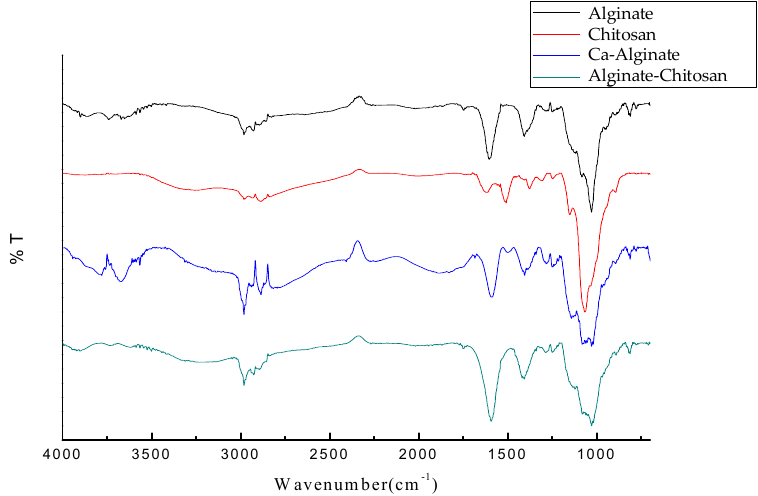
Figure 9. FT-IR spectrum of sodium alginate, chitosan, and calcium alginate composite microspheres. Table 3. Changes in functional groups at different wavenumbers in FT-IR spectra.